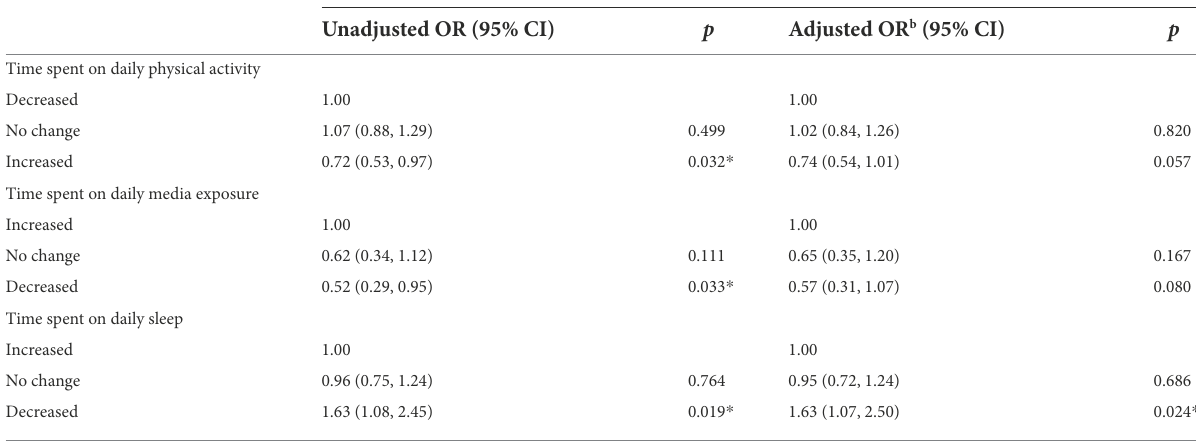
TABLE 5 Associations of preschool children’s mental health problems with lifestyle